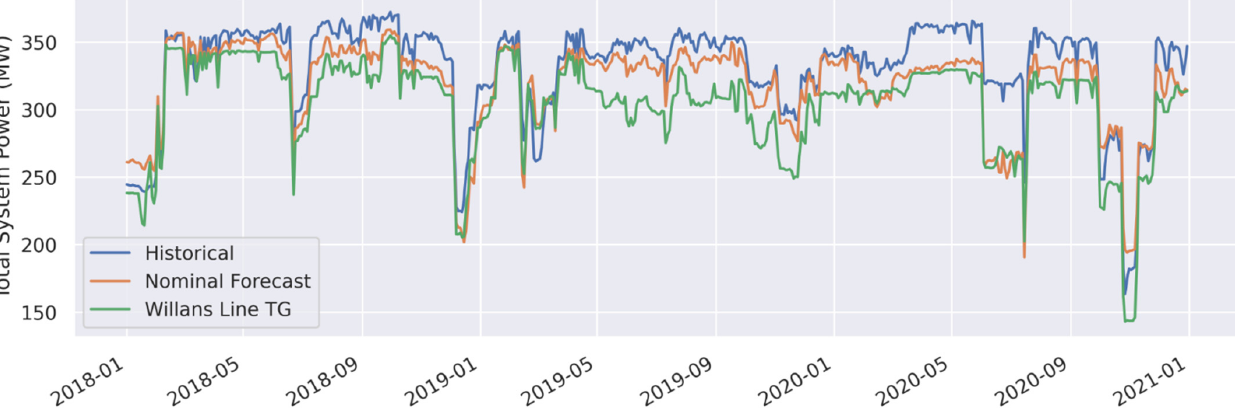
Figure 6. Total system power generation, comparing historically measured data versus the nominal forecast model (including the turbine generator multi-linear regression model) and the Willans Line turbine generator forecast (using a constant value for turbine generator steam consumption rate).